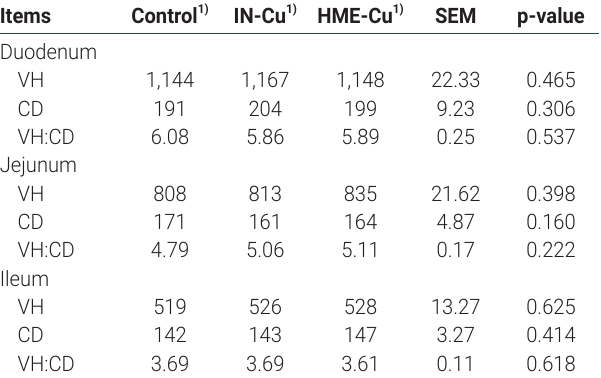
Table 8. Effect of dietary Cu concentrations and sources on Cu bio- availability in broilers Items Control IN-Cu